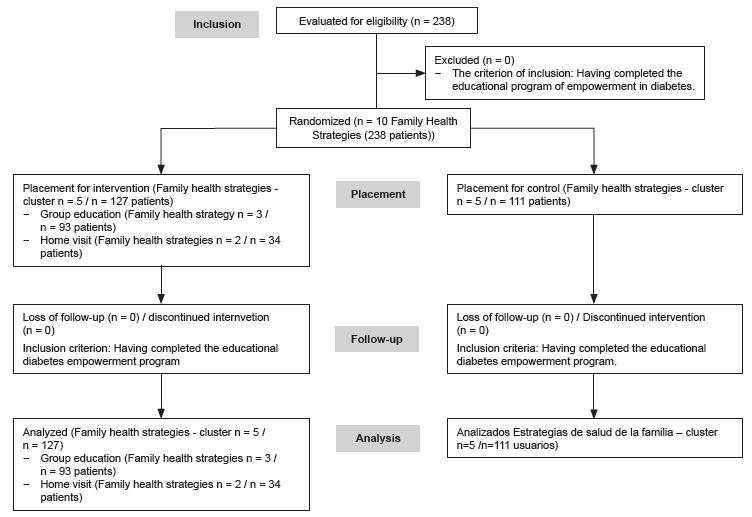
Flow diagram of the progress of clusters and individuals by phases of the
randomized trial.